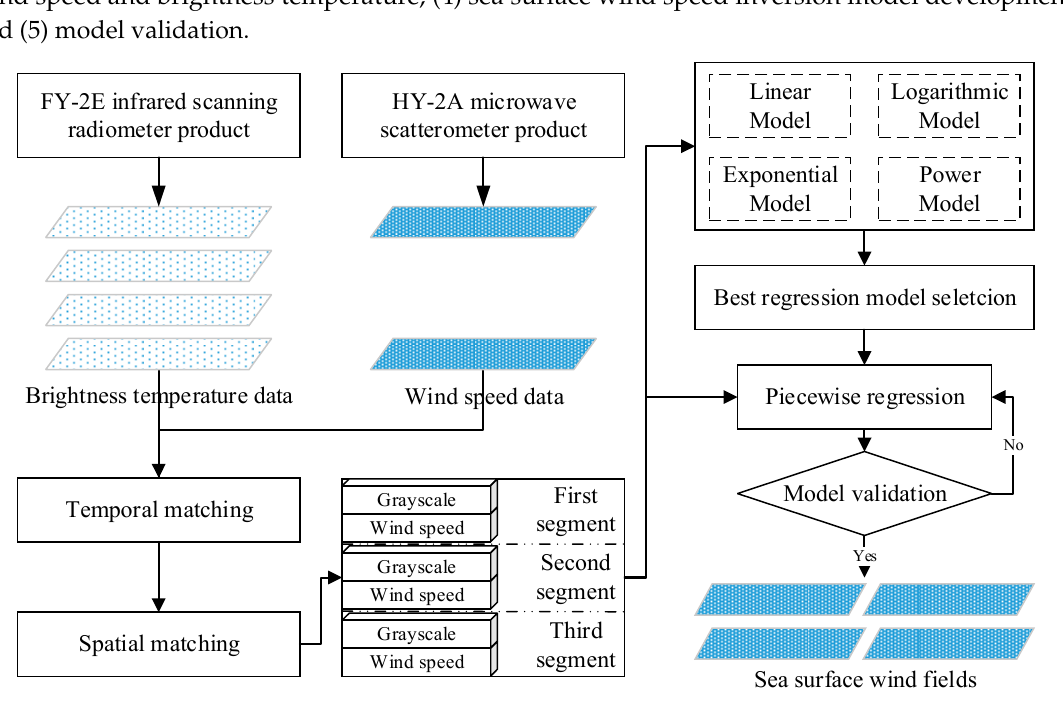
Figure 2. Flowchart of the technical process.